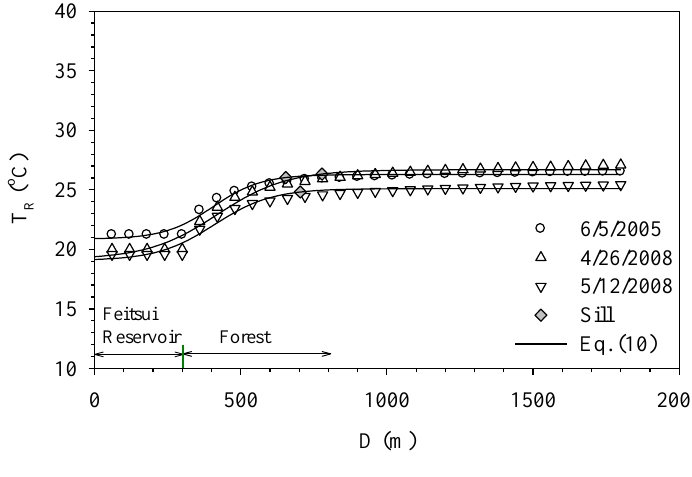
Figure 5. Cooling effect of the Feitsui Reservoir on its ambient natural